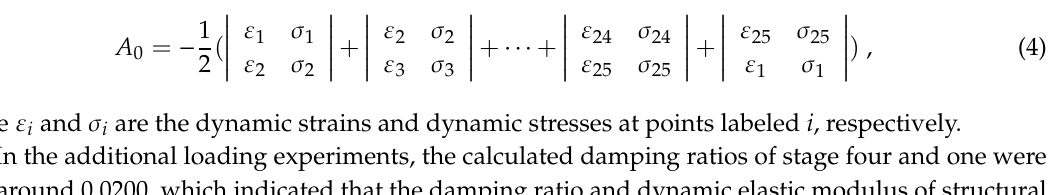
Figure 6. Standard hysteresis loop.